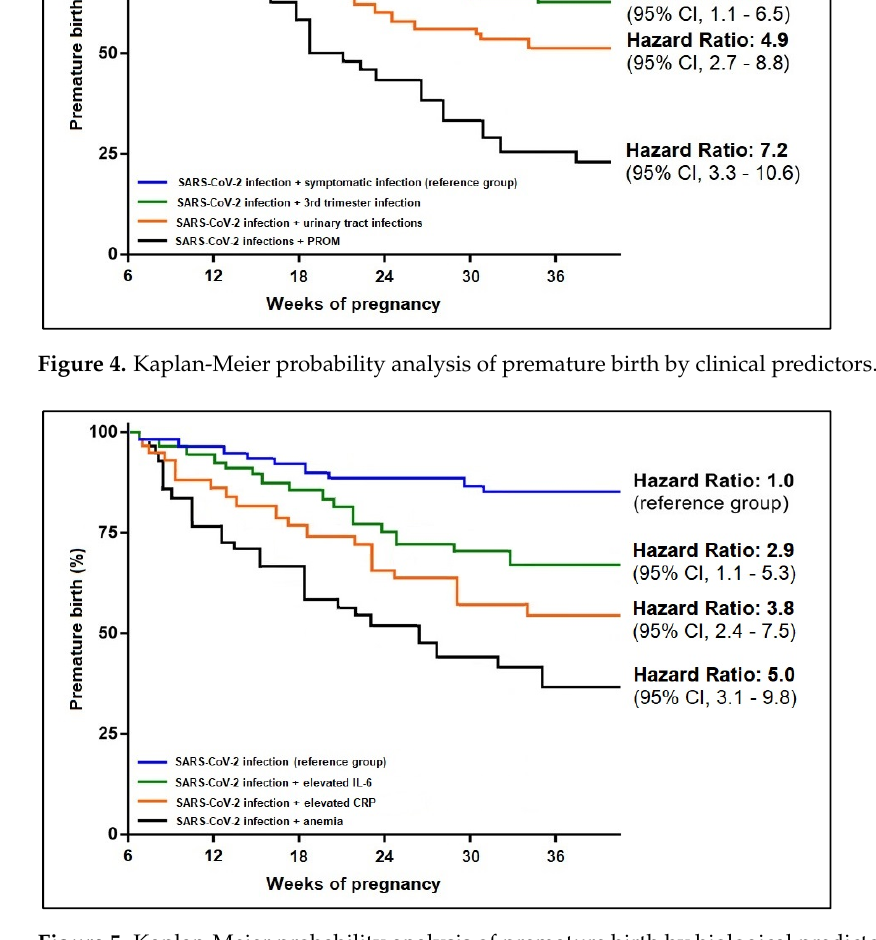
Figure 5. Kaplan-Meier probability analysis of premature birth by biological predictors.